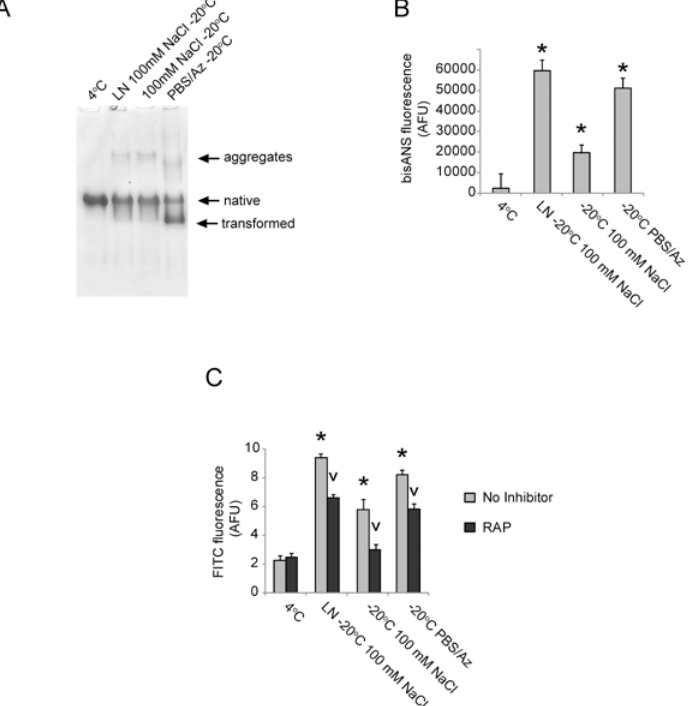
Fig 4. The effect of storage at -20°C on the ability of α 2 M to bind to SH-SY5Y cells. (A) Image of a native PAGE (3 – 8% Tris-acetate) gel showing α 2 M stored in 20 mM sodium phosphate buffer, pH 7.4 containing 100 mM NaCl or in PBS/Az (4°C or -20°C, 10 days). LN indicates that the sample was rapidly frozen in liquid nitrogen prior to storage at -20°C. (B) Corresponding bisANS fluorescence measurements for α 2 M stored as described in (A). The results shown are the mean values of bisANS fluorescence (n = 3 ± SD) in AFU. (C) Flow cytometry analysis showing the binding of α 2 M preparations stored as described in (A) to SH-SY5Y cells. The results shown are the composite geometric mean values of FITC fluorescence for 5000 viable cells (n = 3 ± SD) in AFU and are adjusted for background fluorescence. * Denotes significant increases in cell surface binding of α 2 M stored at -20°C compared to a batch matched sample stored at 4°C. v Denotes significant decreases in cell surface binding of α 2 M as a result of pre-incubation of the cells with